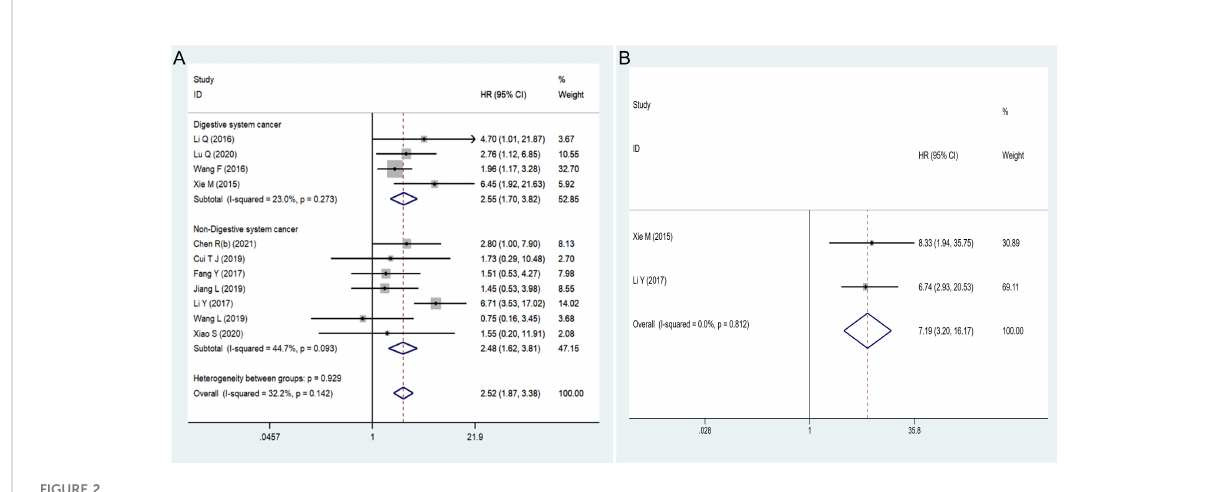
FIGURE 2 Forest plots showed: (A) the correlation between HOXA-AS2 expression and overall survival (OS). (B) the correlation between HOXA-AS2 expression and disease-free survival (DFS).